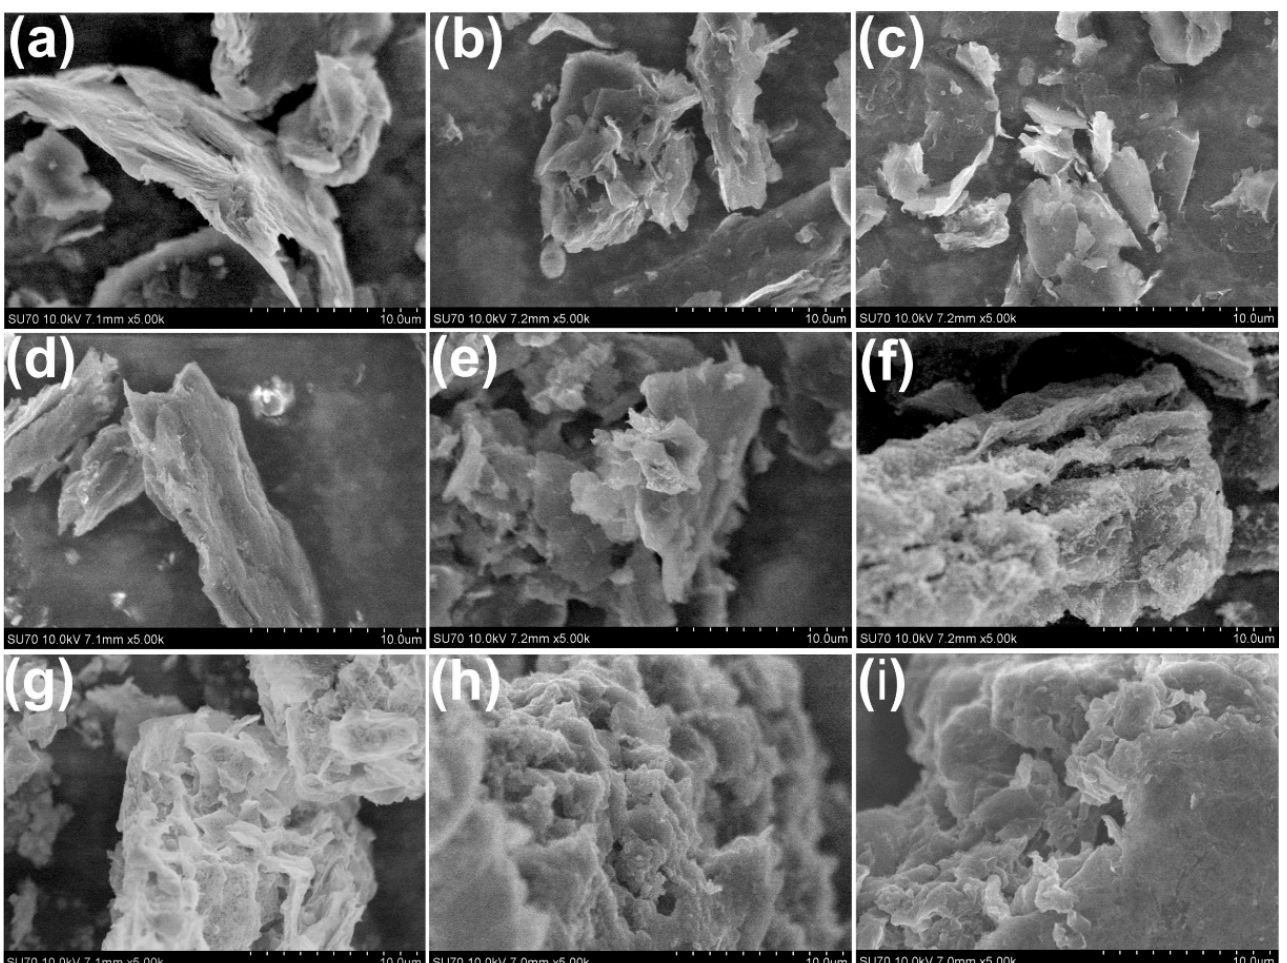
Figure 11. SEM micrographs of pristine graphite and GBS products: graphite ( a ), A001 ( b ), A101 ( c ), P001 ( d ), P101 ( e ), C001 ( f ), C101 ( g ), C010 ( h ), and C011 ( i ).